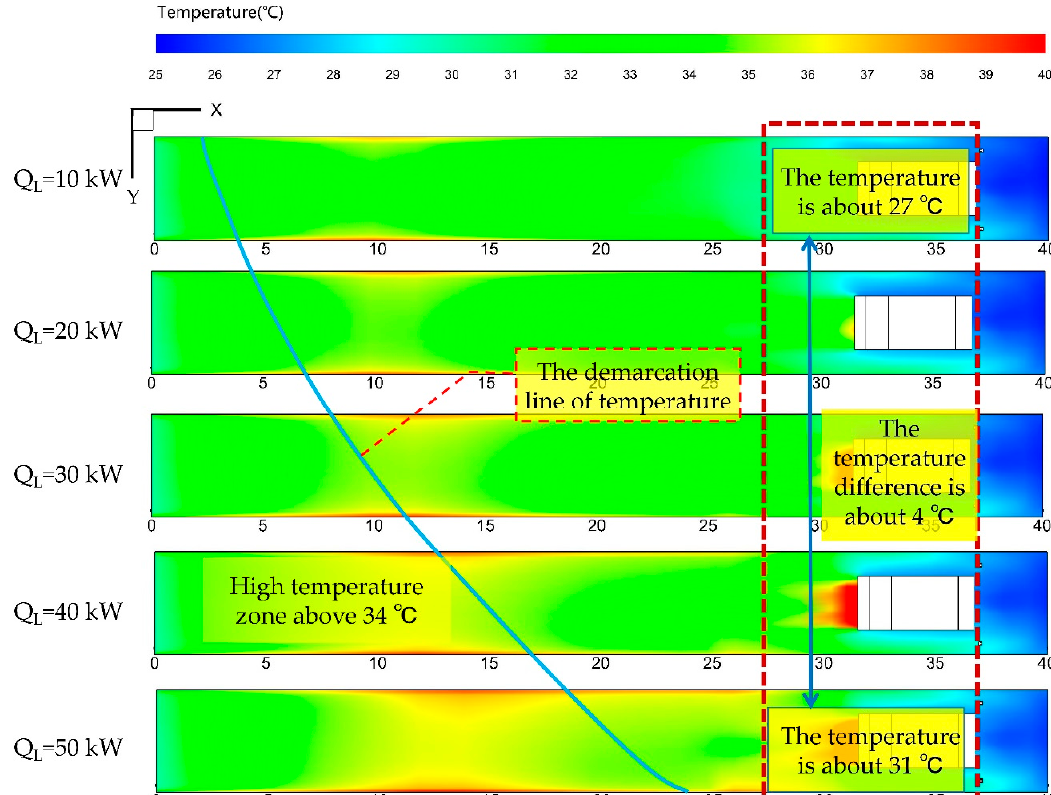
Figure 23. Streamlines of the NFFE ventilation system.